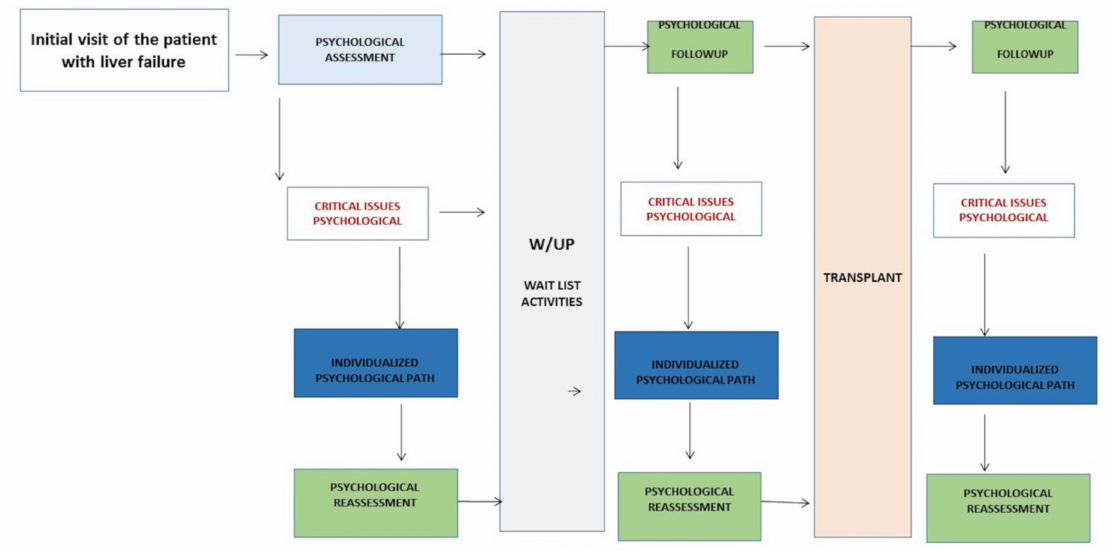
Figure 1. Summary scheme of taking charge of the patient by the ISMETT Clinical Psychology Unit. The scheme visualized the psychological assessment of the patient with liver disease in ISMETT from the first visit to the